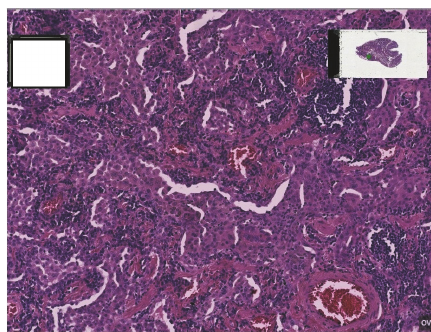
Figure 3: 10x lung view showing dense accumulation of intra- alveolar macrophages. Classic histological DIP